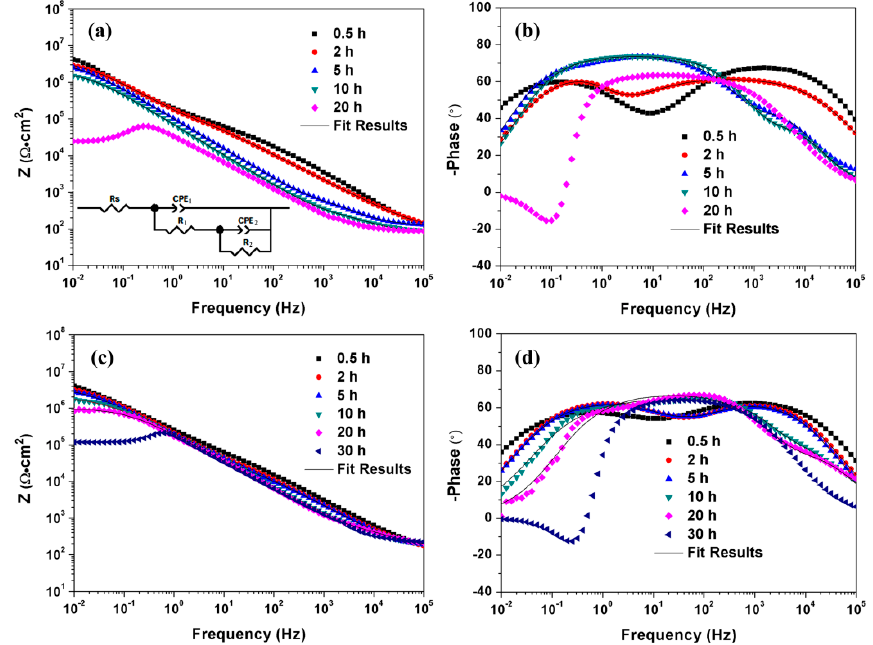
Figure 8. Bode plots and fitting curves of MAO coatings on AZ31 ( a , b ) and AZ91 ( c , d ) alloys after immersion in 0.1 M NaCl solution for different times. The illustration is the equivalent circuit model for fitting the Bode plots before local corrosion failure.